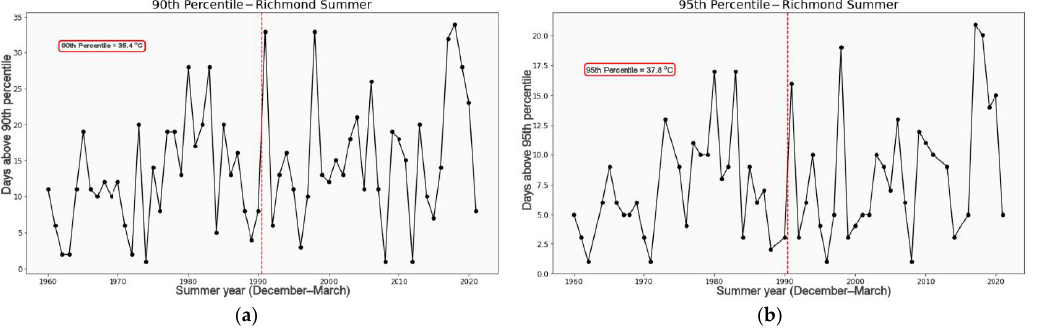
Figure 5. Number of days above the ( a ) 90th percentile and ( b ) 95th percentile across the time series for Richmond. The red outlined box denotes the percentile value that is used as the baseline marker and the dotted red line splits the two climate periods.